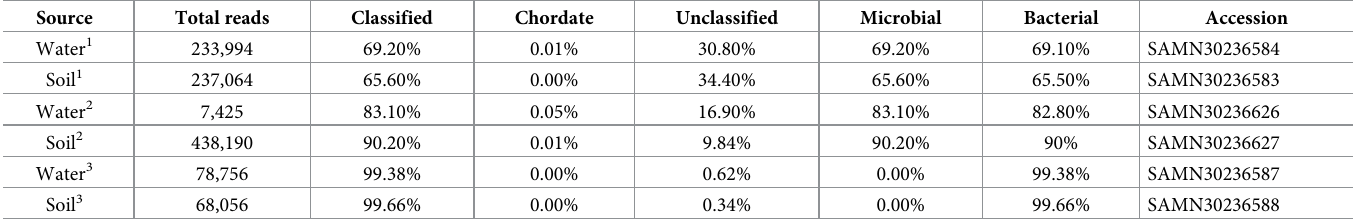
Table 2. Overall read classification from all the sequencing methods used in this study 1 -Culture enrichment and metagenomic sequencing; 2 - Direct metagenomic sequencing; 3 -16S amplification-based